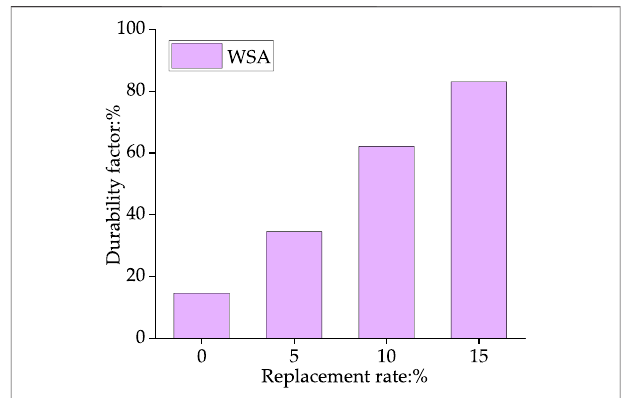
FIGURE8| EffectofWSAcontentonthedurabilityfactorofconcrete(Al- Akhras, 2011).